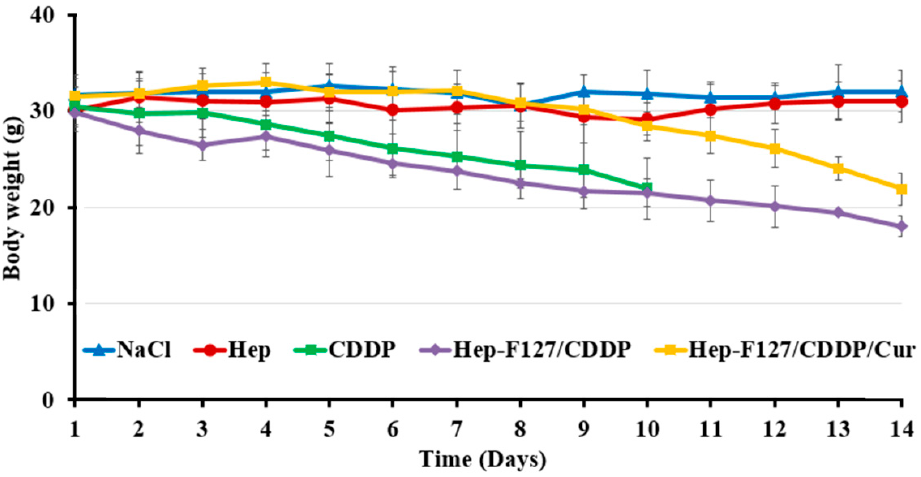
Figure 7. Body weight of the tumor-bearing immunodeficiency mice after materials-treated 14 days.